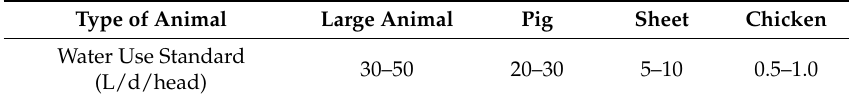
Table 3. Standard for a rainwater harvesting utilization system for household animal husbandry water